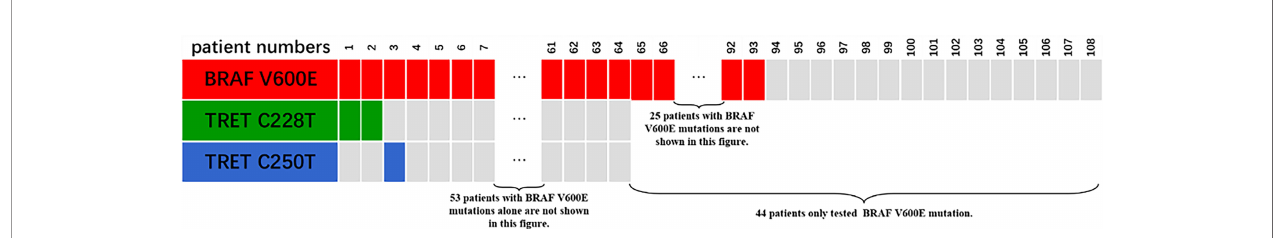
FIGURE 1 | Genetic test results of 49 cases of FNMTC patients. Forty-nine of 106 included FNMTC patients were tested for BRAF V600E mutations, and 28 were also tested for TERT promoter mutations, while only 1 (3.57%) of the FNMTC patients tested positive for TERT promoter mutation (C228T) and 39 (79.59%) for BRAF V600E mutation.